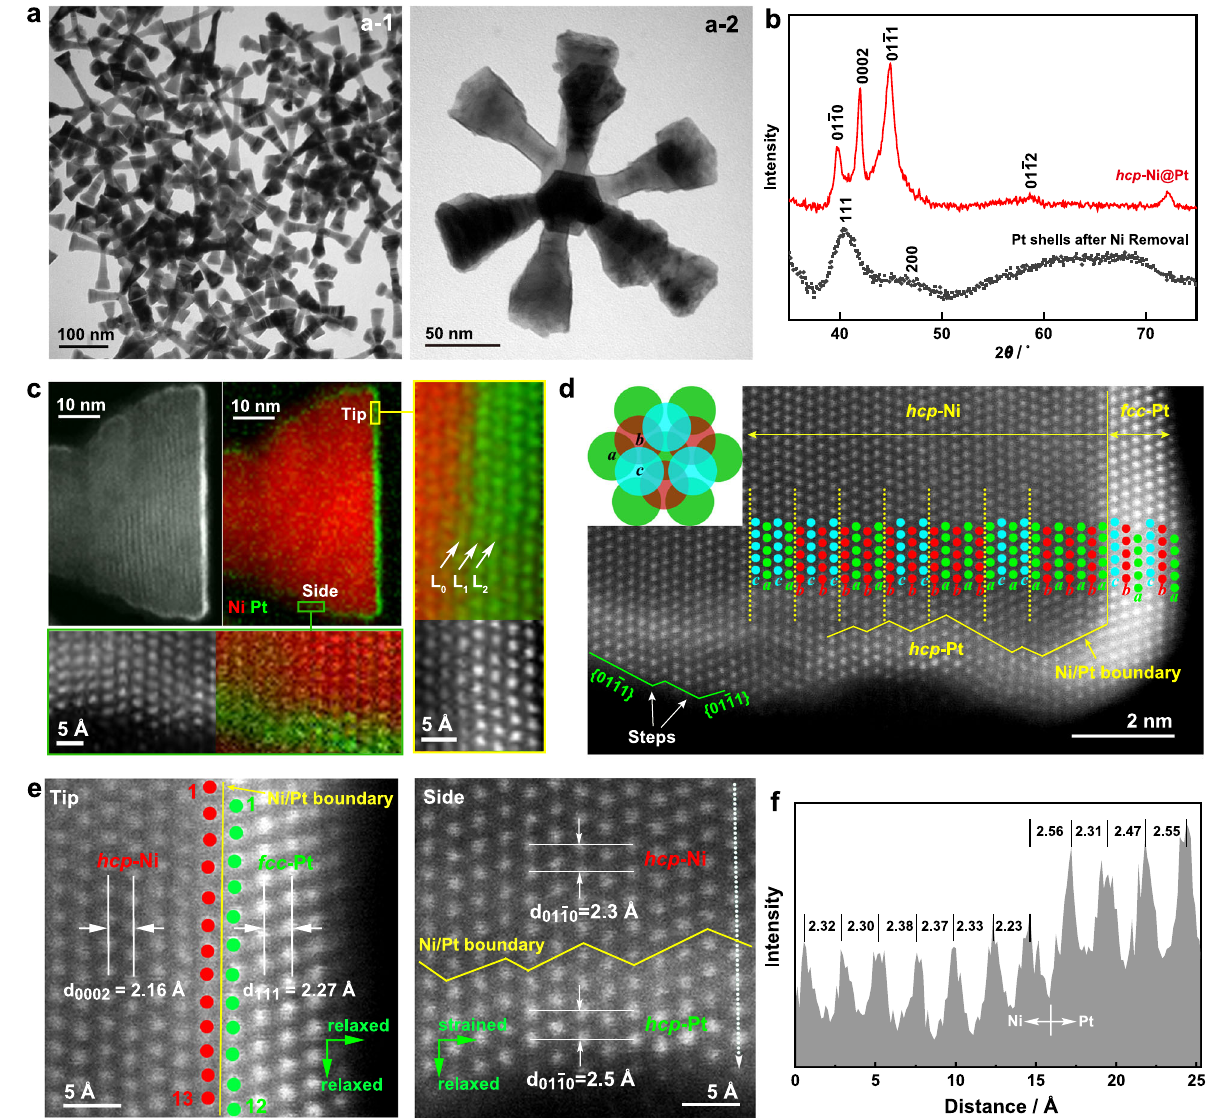
Fig. 2 | Structural and phase analysis of the hcp -Ni@Pt-skin core-shell nano- branches.a Low-magni fi cationTEMimages. b XRDpatternsofthe hcp -Ni@Ptcore- shell nanobranches and Pt shells after etching of Ni. c – f C s -corrected HR-STEM analysis. c Atomic-resolution EELS mappings acquired at the tip and side of the nanobranches with corresponding HAADF-STEM images. d Phase analysis of the nanobranches, showing an hcp structure of both the Ni core and the Pt skin at the